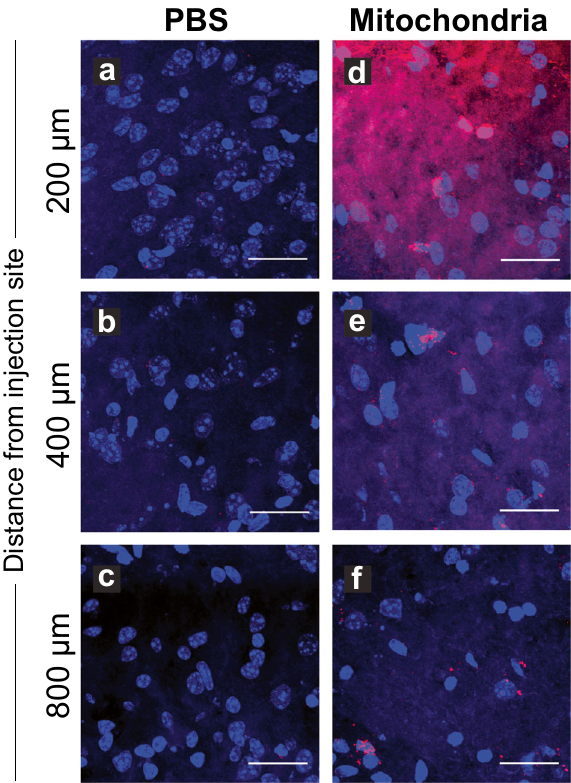
Fig. 2 Stereotactic injection facilitates ef fi cient delivery of mitochondria into the brain parenchyma. Injected brains were harvested, cryo-sectioned and stained with nuclear stain DAPI (blue). a – c Control brain injected with PBS, d – f Experimental brain injected with exogenous mitochondria labeled with MitoTracker Red CMXRos (Invitrogen). Both mice were injected directly into the striatum and striatal sections were imaged with confocal micro- scopy. The images were acquired at various distances from the injection site: a , d 200 μ m, b , e 400 μ m, and c , f 800 μ m. Mitochondria were found to diffuse in the parenchyma and detected over 1 mm from the injection site. Scale bar, 25 μ